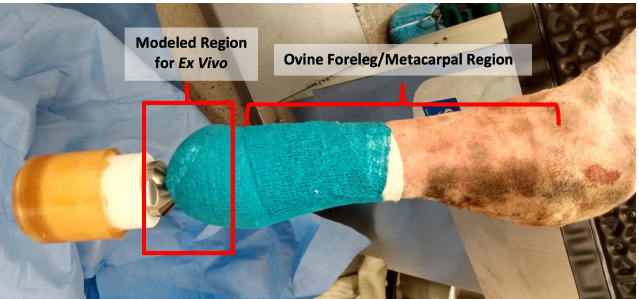
Figure 1. In Vivo ovine model immediately post surgery (from a separate IACUC-approved study). The ex vivo model was developed to simulate this situation, using sheep skin obtained from the metacarpal region of sheep cadavers and maintained in an upside down position to represent the sheep standing upright.